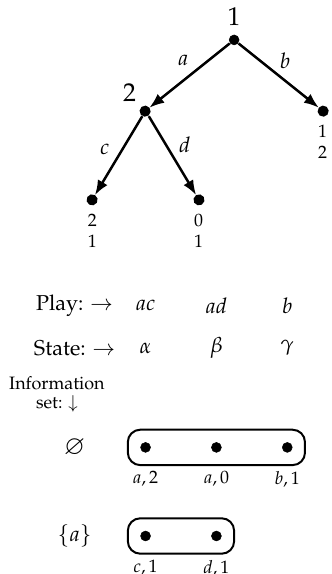
Figure 6. A perfect-information game and a model of